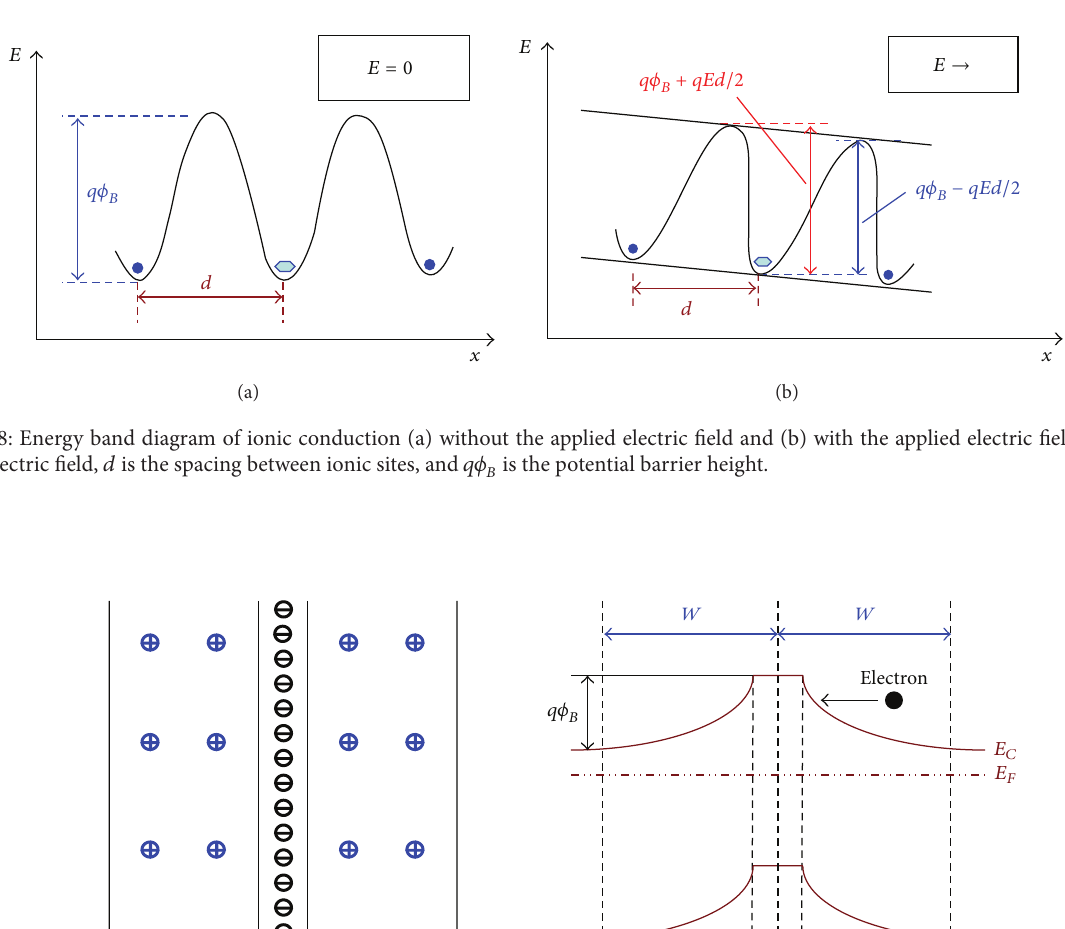
Figure 27: Logarithm of the current density plotted as a function of the logarithm of the applied voltage under negative bias at room temperature.